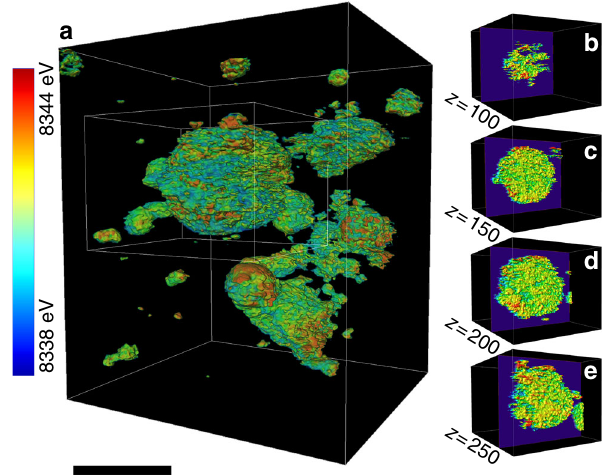
Fig. 3 Three-dimensional distribution of Ni valence states over the polycrystalline ensembles after the heating sequence illustrated in Fig. 1a. a The 3D distribution of nickel valence states represented by Ni K-edge energy. The single-voxel thick slices through different depths of a particle (30 nm thick slices at 50 voxels apart through the largest particle in a are shown in b-e . The scale bar is 8 μ the reductive phase transformation (this study), the phase transformation propagates from the new (reduced) phase into the parent (oxidized) phase. We calculated the local valence curvatures over the isosurface of each topography and color coded the isosurfaces (Fig. 4a – c) based on the corresponding local valence curvature, with the red and blue indicating positive and negative local curvatures, respectively. Although we only display